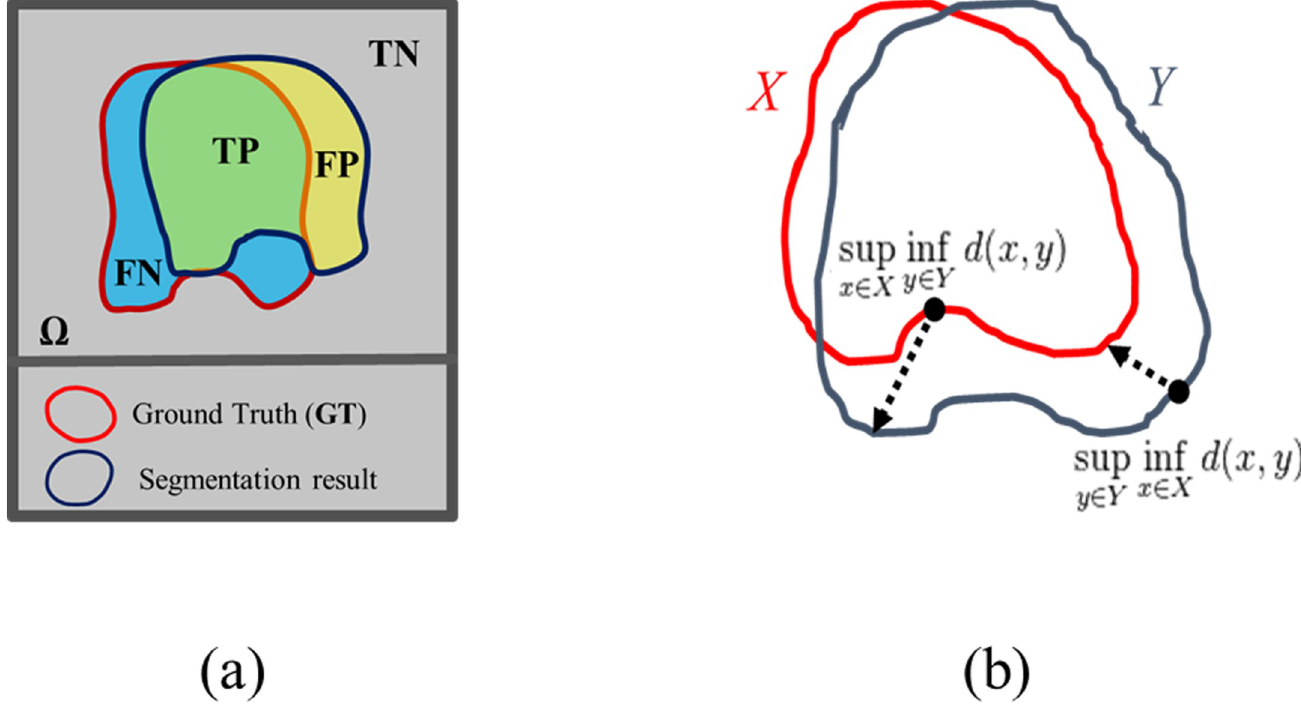
Fig 3. Segmentation accuracy measures. (a) In the segmentation quality measurements, there are 4 regions to be considered as: True positive (TP), false positive (FP), true negative (TN), and false negative (FN). (b) The calculation of the HD between the red line X and the blue line Y.